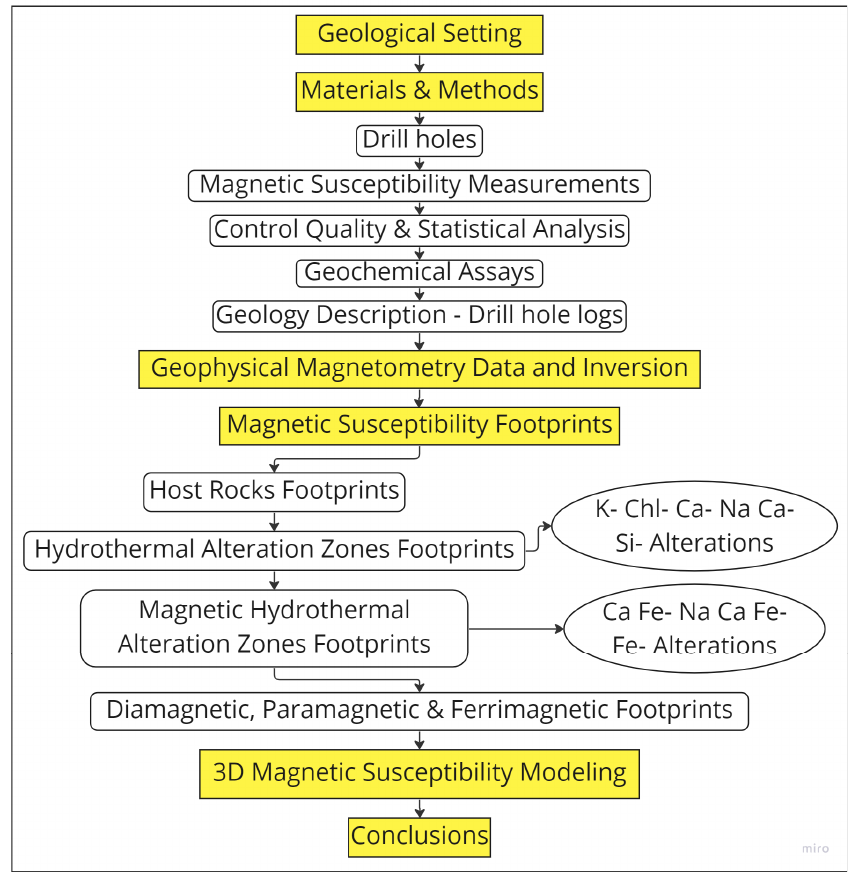
Figure 7. Flowchart that summarizes the steps, methods and materials used in this study.